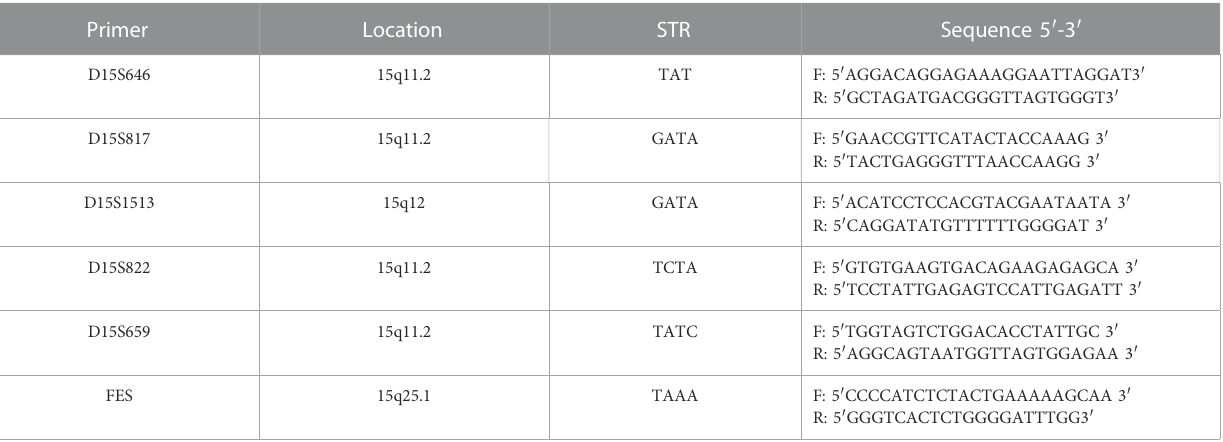
TABLE 1 Primers for the